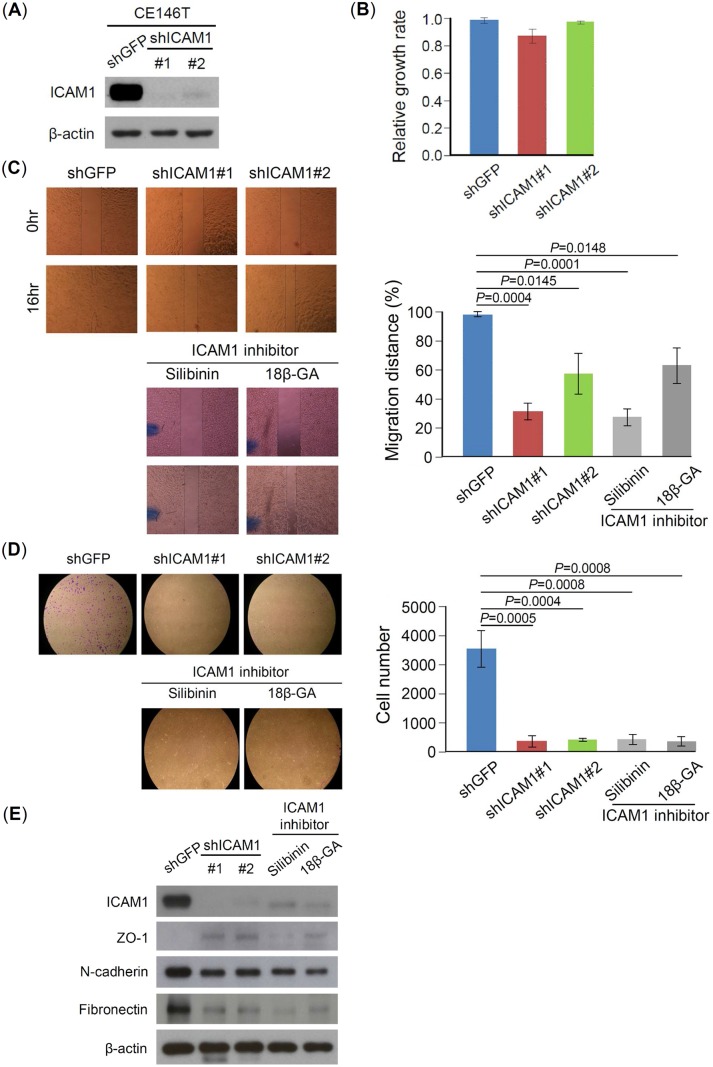
ICAM1 increases metastatic potential of cancer cells.(A) ICAM1 expression was knocked down using two kinds of shRNA, shRNA#1 target sequence is: GCCCGAGCTCAAGTGTCTAAA, and shRNA#2 target sequence is: CCTCAGCACGTACCTCTATAA. (B) Cell growth of CE146T was analyzed using MTT assay. ICAM1 knockdown did not significantly affect the growth of CE146T cells. CE146T-shGFP served as control. The effects of ICAM1 knockdown on cell migration and invasion abilities were analyzed using (C) wound-healing and (D) matrigel invasion assays, respectively. Both experiments were performed in triplicate (mean ± SD). (E) The expression of EMT markers was determined using western blot assay. CE146T was treated with ICAM1 inhibitor silibinin (2μM) or 18β-GA (10μM) for 24hr. The expressions of epithelial marker ZO-1 and mesenchymal markers N-cadherin and fibronectin were examined using specific antibodies. β-actin served as loading control.